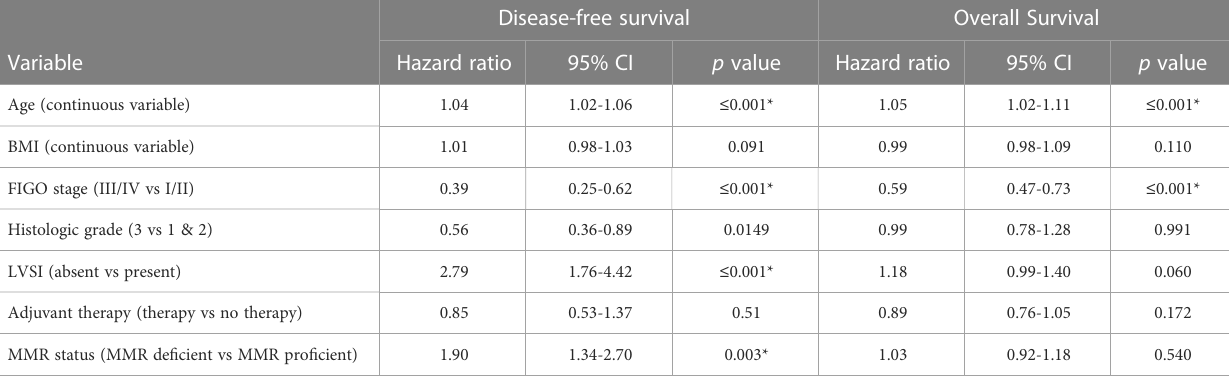
TABLE 4 Multivariate analysis for endometrioid EC disease-free survival and overall